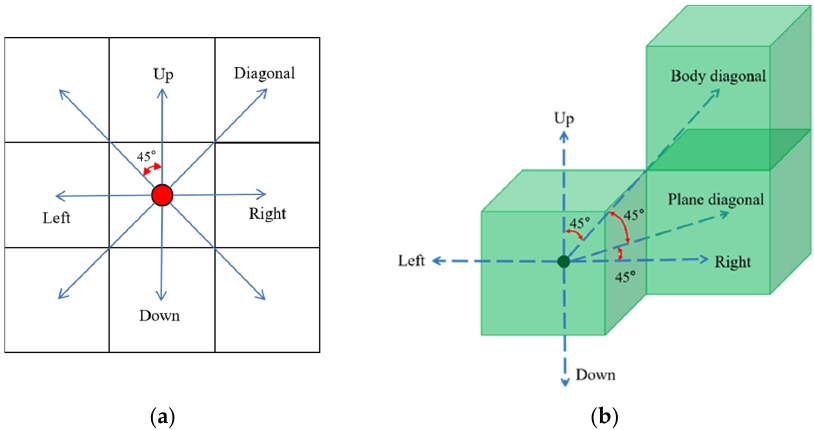
Figure 2. Search-angle limitation of JPS algorithm. ( a ) Limitation of extension angle of JPS algorithm in 2D structure, ( b ) Limitation of extension angle of JPS algorithm in 3D structure.